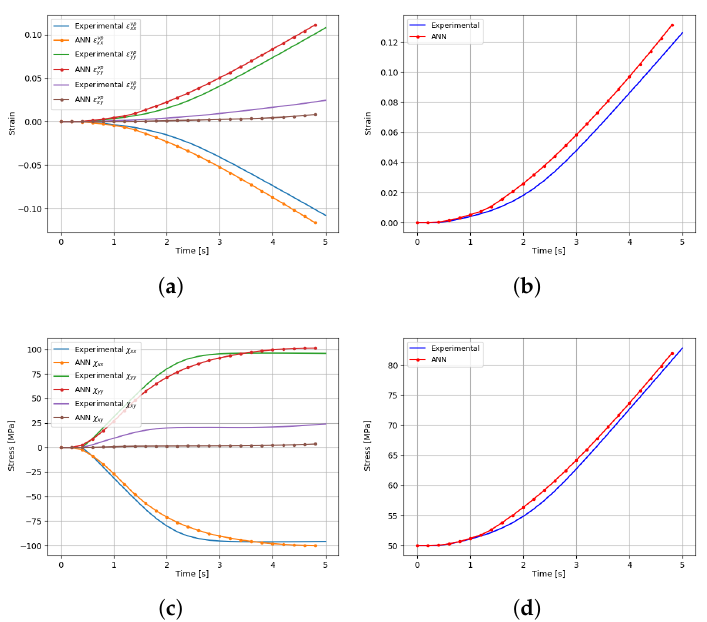
Figure 19. Evolution of the internal state variables for the selected points in the butterfly test: ( a ) vis- coplastic strain tensor ε vp , ( b ) back stress tensor χ , ( c ) plastic strain p and ( d ) isotropic (hardning/drag) stress R . Comparison between the ANN model and (virtual) experimental values